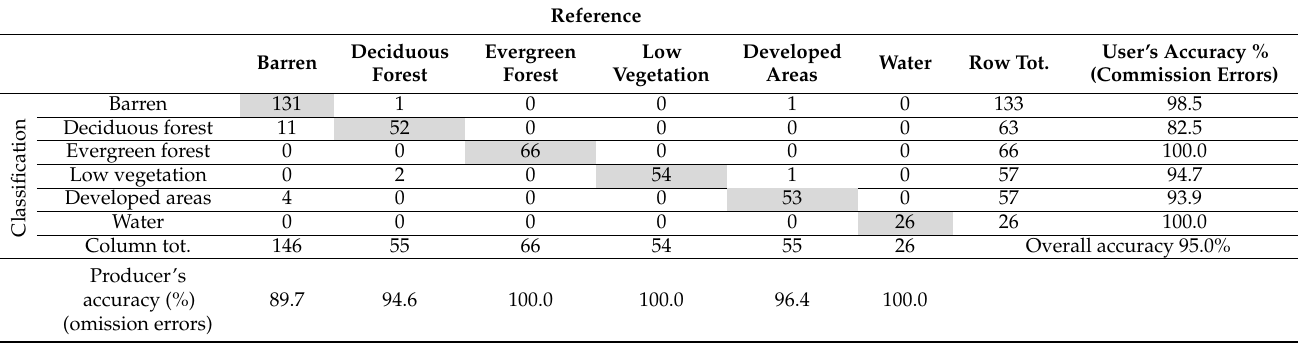
Table 2. The error matrix for the classification of 1976. Values in the cells represent the number of objects, while accuracies are reported with the percentage of land